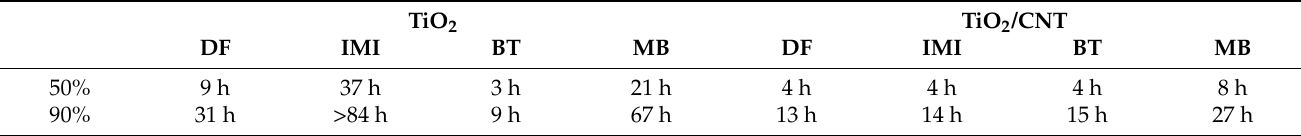
Table 2. Overview of time necessary to achieve 50% and 90% of efficient photocatalytic degradation for studied pollutants. Results are obtained based on developed model prediction.